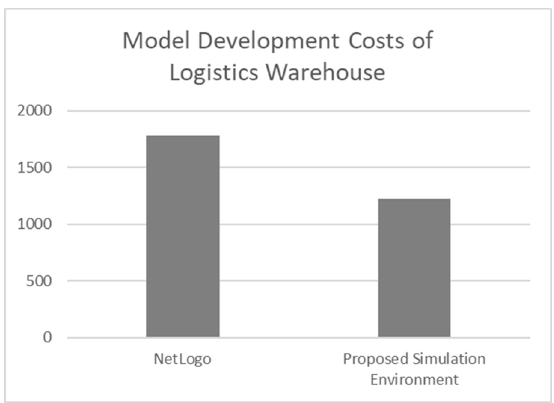
Figure 11. Cost of modeling distribution warehouse with NetLogo and prototyped simulation